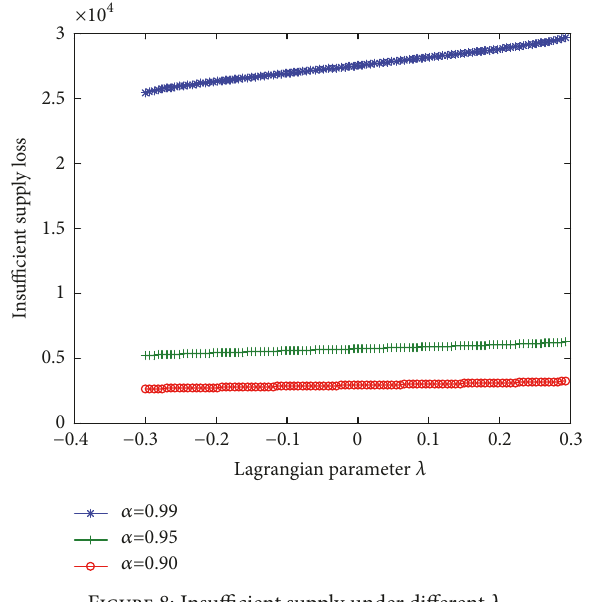
Figure 8: Insufficient supply under different 𝜆 .